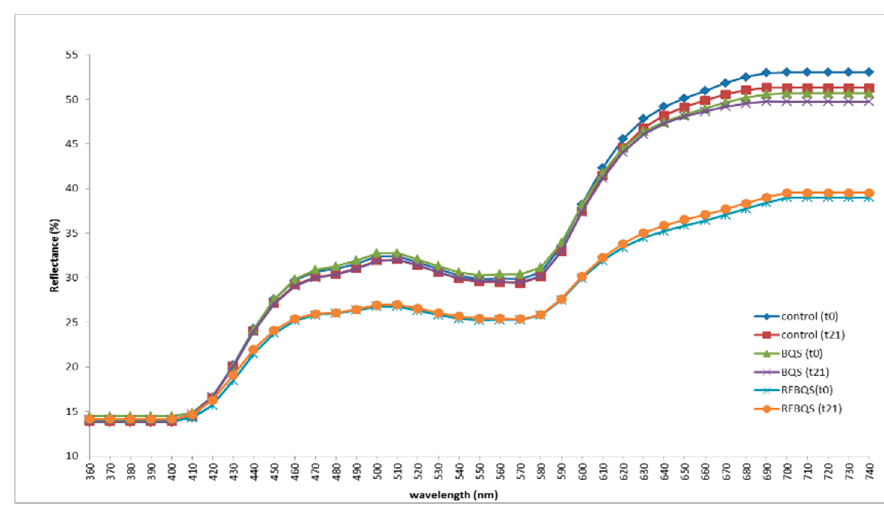
Figure 1. Reflectance spectra (360–740 nm) of the Bologna-type sausages (control, sausage with black quinoa seeds (BQS) and sausage with its fibre-rich fraction (RFBQS)) at the beginning (day 0) and at the end of the storage period (day 21).